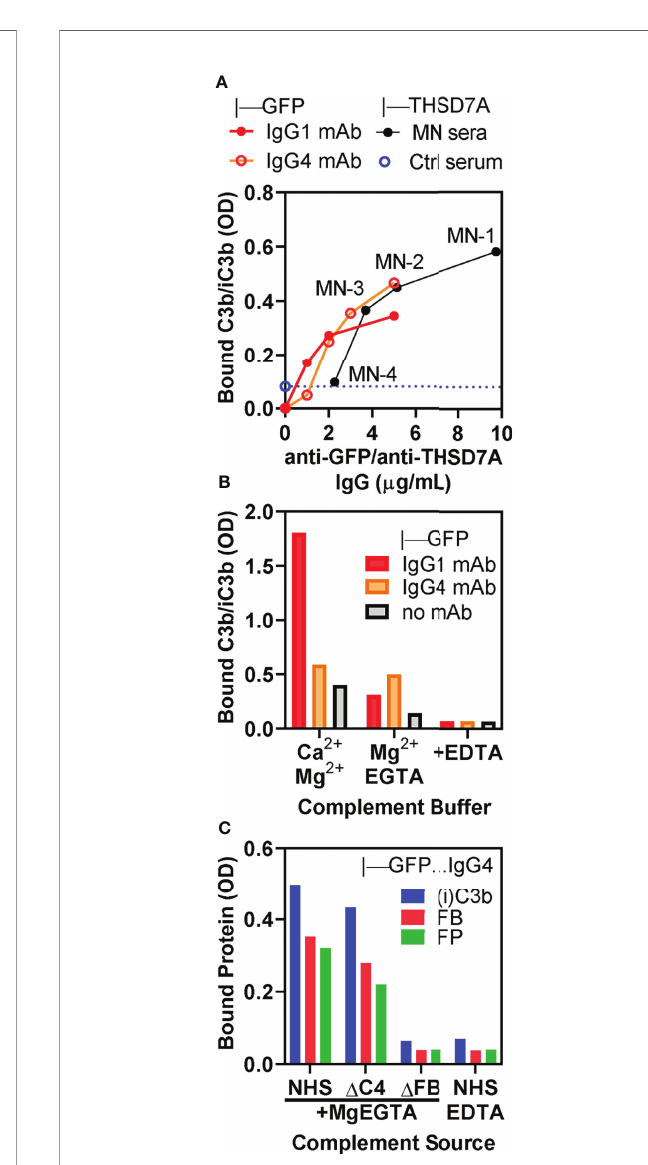
FIGURE 6 | In vitro complement activation by THSD7A ICs in MgEGTA buffer, which inhibits the classical and lectin pathways. (A) Concentration dependence of C3b/iC3b deposition on ICs formed by anti-THSD7A antibodies (black circles) from MN-1, MN-2, MN-3 and MN-4 sera (all diluted 1/25) bound to immobilized THSD7A or by anti-GFP human IgG1 (red circles) and anti-GFP IgG4 (orange circles) mAbs bound to immobilized GFP. (B) C3b/iC3b deposition on ICs formed by IgG1 mAb (1 m g/mL) and IgG4 mAbs (3 m g/mL) bound to immobilized GFP. Complement activation was performed using 10% NHS diluted in buffer containing Ca 2+ and Mg 2+ , MgEGTA, or EDTA. Inhibition of classical and lectin pathways by MgEGTA reduced C3b/iC3b binding to IgG1 ICs by >80% but had minimal effect on C3b binding to IgG4 ICs. (C) The deposition of C3b/iC3b (blue), factor B (FP, red) and properdin (FP, green) on ICs formed by anti-GFP IgG4 mAb (3 m g/mL) was completely abolished when using FB-depleted serum or normal serum containing EDTA as complement source, but largely unchanged in C4-depleted